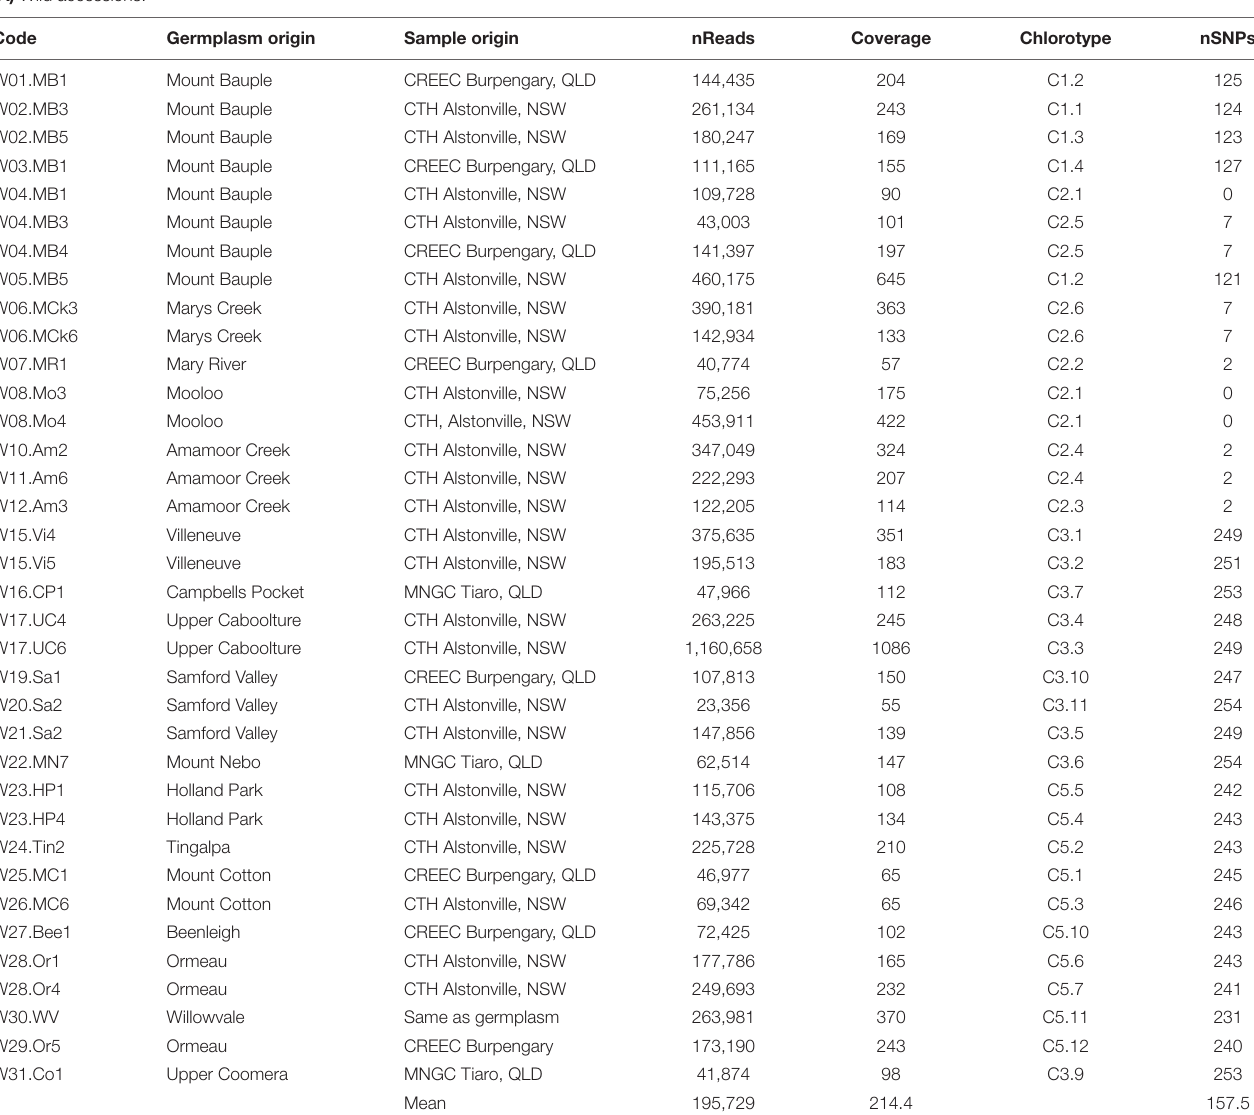
TABLE 1 | Origin and source of wild (A) and cultivated (B) Macadamia integrifolia accessions. (A) Wild